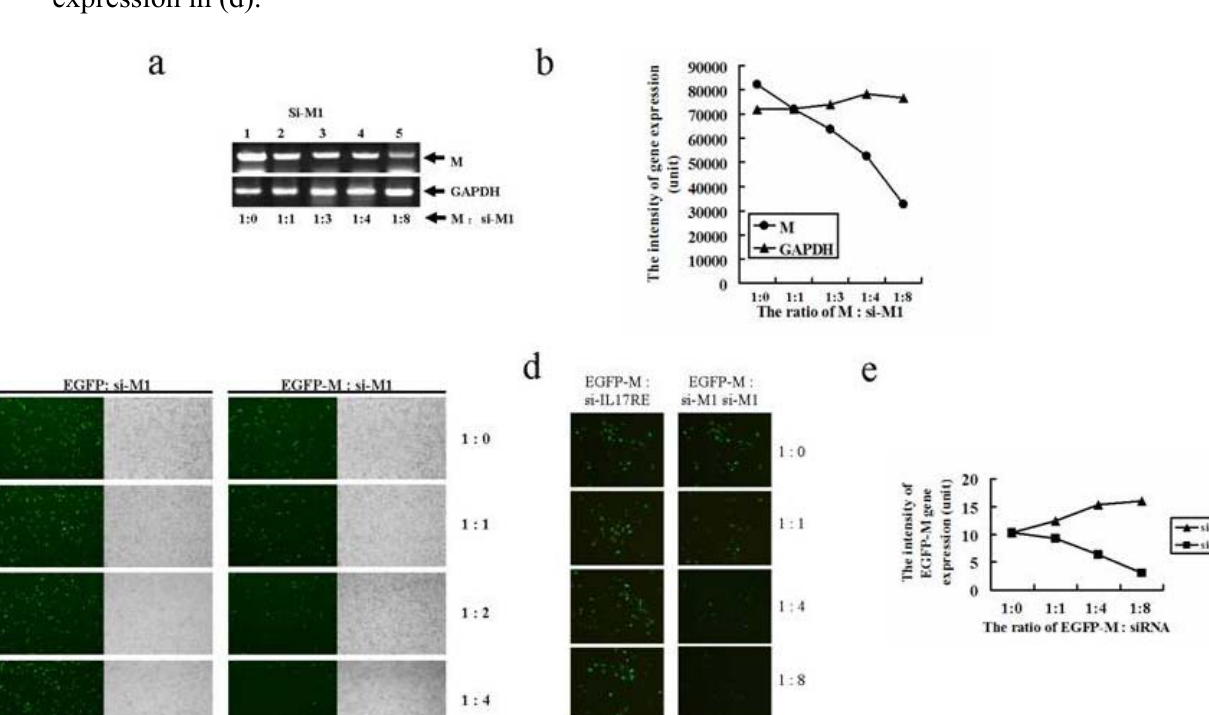
Figure 3. The inhibitory effect of siRNA1 on SARS-CoV M gene expression. (a)RT-PCR analysis on si-M1 mediated M gene repression. About 1  g of pCMV-Myc-M was co-transfected with increased doses of si-M1. The reaction products were subjected to RT-PCR analysis using SARS-M and GAPDH primers. (b) Quantitation of the RT-PCR results in (a). (c) si-M1 specifically inhibited pEGFP-M fusion gene but not pEGFP gene expression. About 1  g of either pEGFP-M or pEGFP was co-transfected with increased doses of si-M1. (d) si-M1 but not si-IL-17RE effectively inhibited EGFP-M gene expression. About 1  g of pEGFP-M plasmid was co-transfected with increased doses of either si-M1 or si-IL17RE. (e) Flow cytometric analysis on the intensity of pEGFP-M